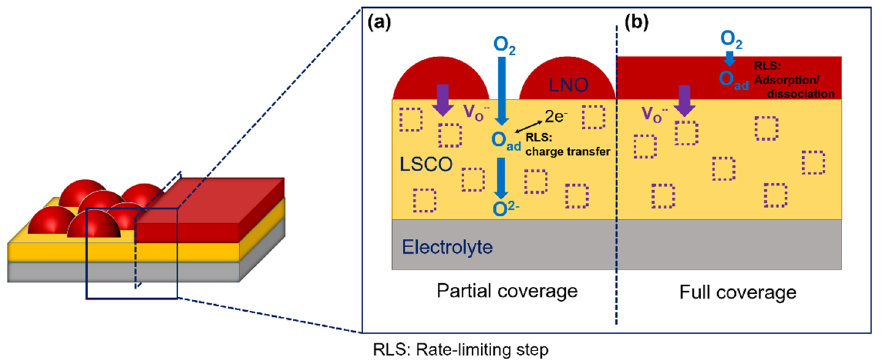
Figure 5. Schematic of the surface exchange kinetics of LSCO films with ( a ) partial LNO coverage and ( b ) full LNO coverage. The active oxygen vacancies in LSCO with partial LNO coverage lead to fast oxygen incorporation into the LSCO film while full LNO coverage hinders the oxygen incorporation into LSCO.